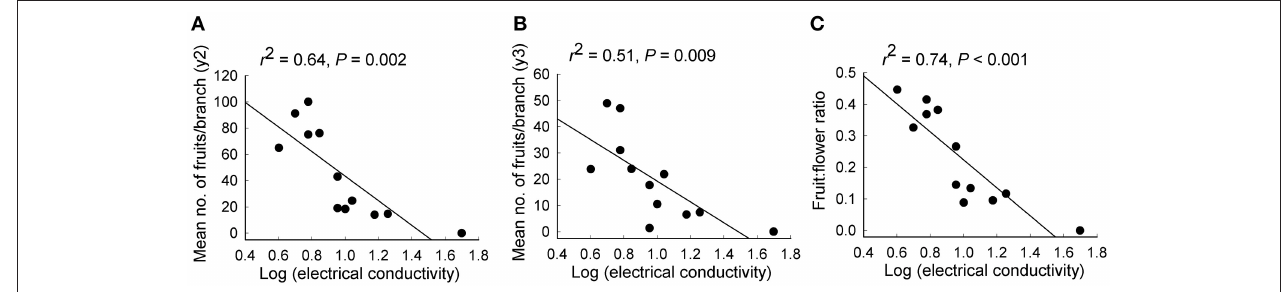
FIGURE 3 | Relationships between soil electrical conductivity and (A,B) the mean number of fruits per branch in each of 2 years and (C) fruit:flower ratio for 12 populations of Eucalyptus wandoo . Regression lines are presented with r 2 - and P -values.